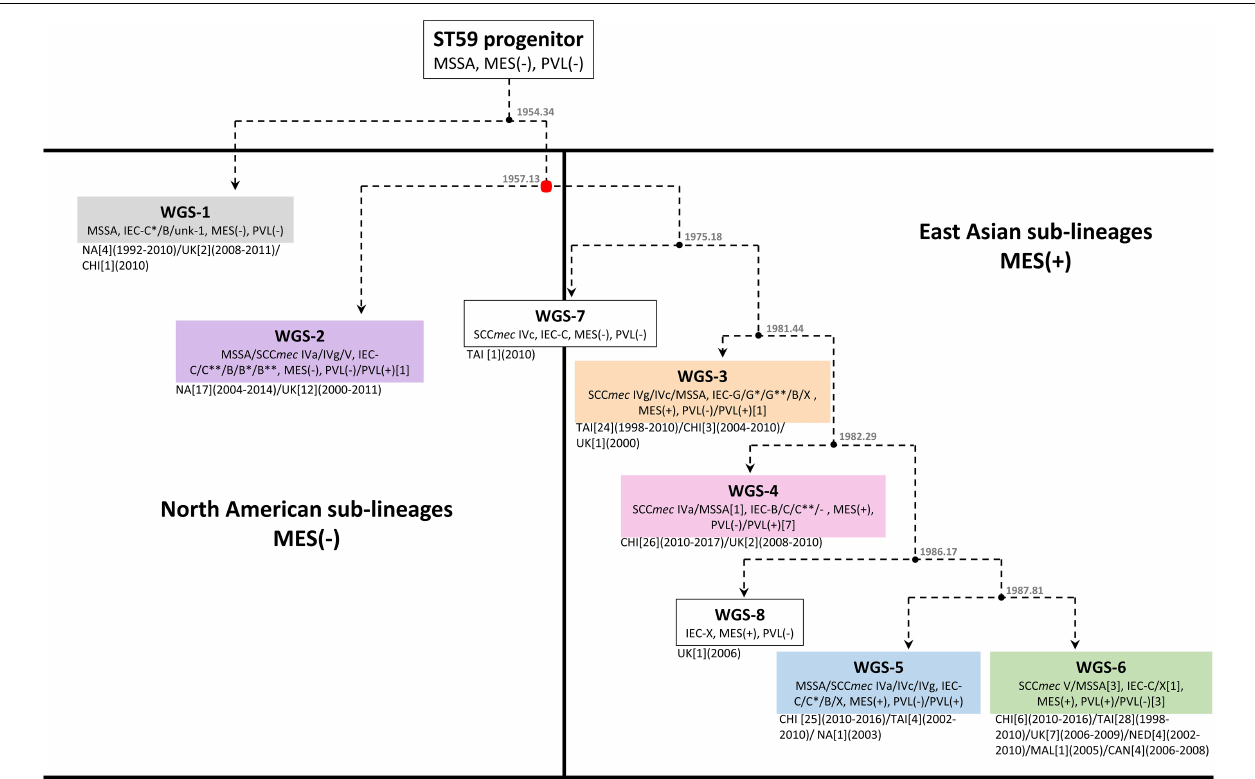
FIGURE 2 | Proposed evolutionary history of S. aureus ST59 showing the separate North American and East Asian sub-lineages. Box colors correspond to the sub-group (WGS-1 to 6) colors described in Figure 1 . Nodes are represented by black circles with the estimated node date (from BEAST analysis) shown. Molecular data is indicated for each branch, with the numbers of isolates carrying a trait indicated in square brackets when it represents an exception. Location of isolation is shown, along with the number of isolates from each location in square brackets, and the years of isolation in round brackets. The red node represents the point at which the NA and EA sub-lineages co-evolved, as described by Ward et al.